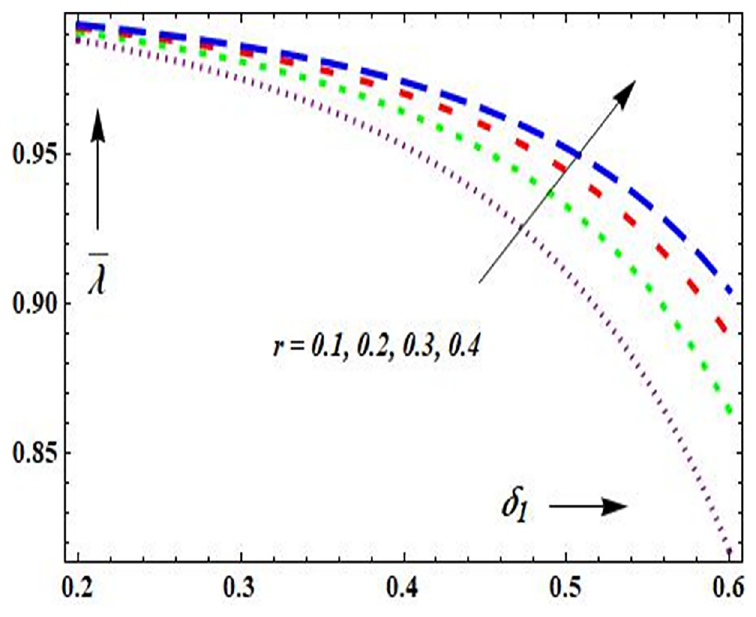
Fig 2. Plot of � λ on r & δ 1 with ϕ ¼ π